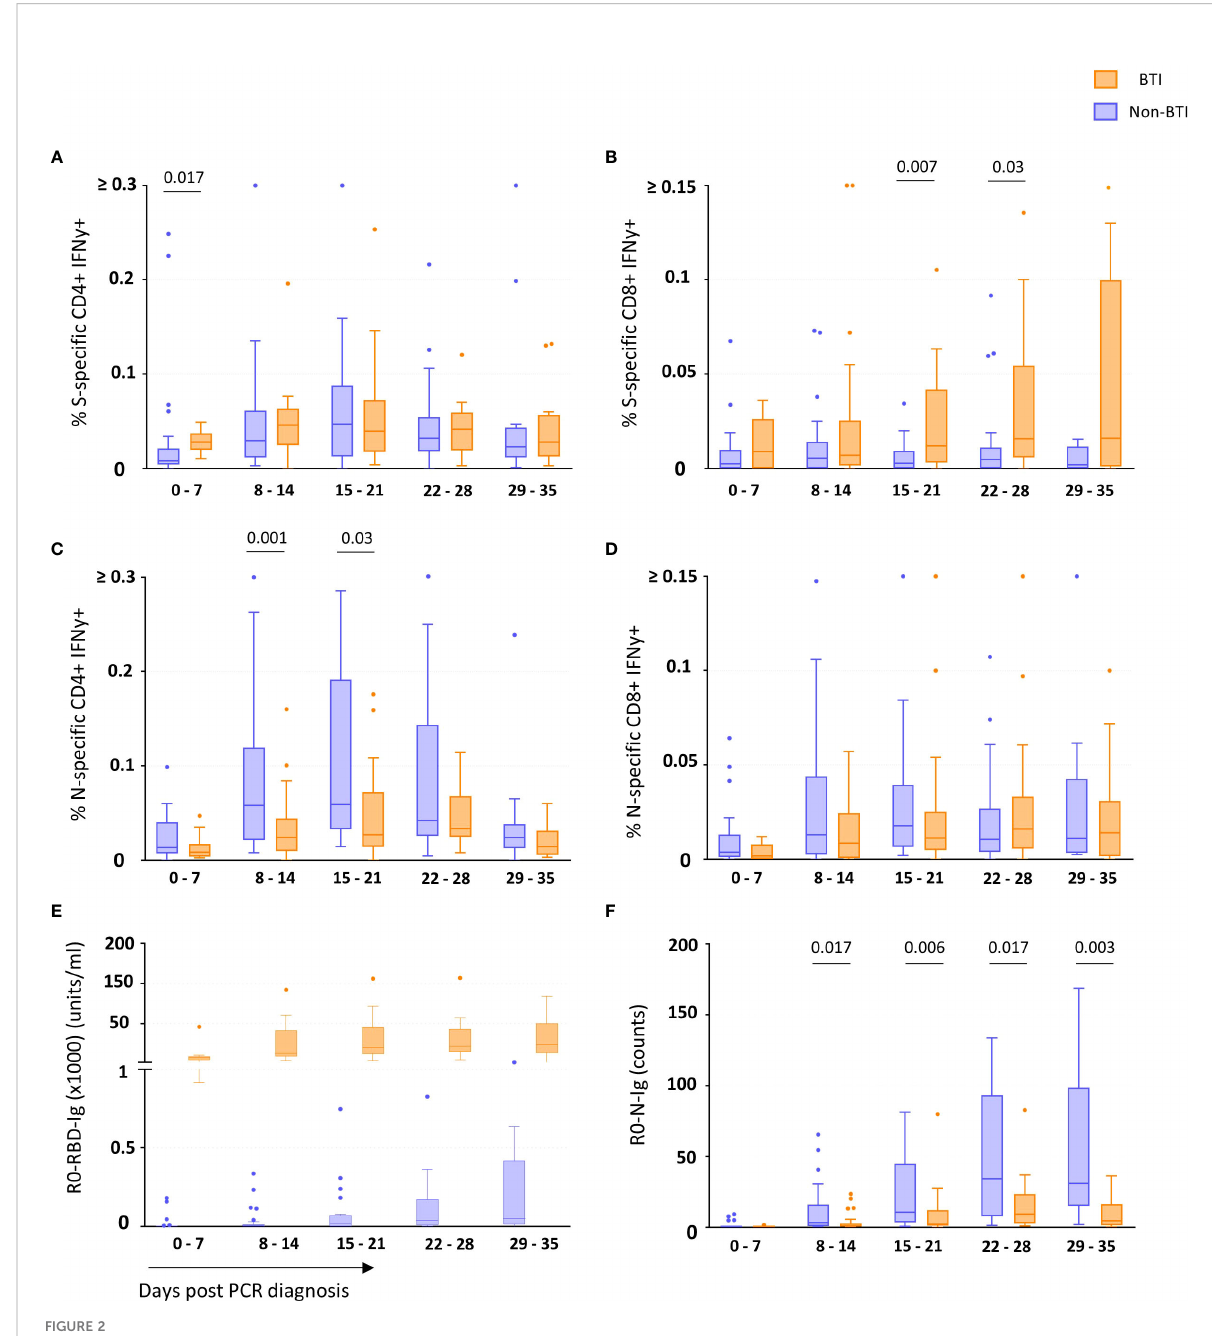
FIGURE 2 T cell and binding antibody responses targeting vaccine-encoded Spike and non-encoded Nucleocapsid protein. The frequency of Spike- speci fi c IFNy+ CD4+ (A) and CD8+ (B) and Nucleocapsid-speci fi c IFNy+ CD4+ (C) and CD8+ (D) T cells and concentration of binding antibodies against the Spike-Receptor Binding Domain (RBD) (E) and Nucleocapsid (N) (F) in breakthrough infections (orange boxes) and non- breakthrough infections (blue boxes) are shown as median and quartiles enclosing 50% of the datapoints, whiskers extend up to the last point inside 1.5*(IQ3 - IQ1) range (Tukey de fi nition). Speci fi c T cell responses were detected after in vitro antigen-stimulation of freshly isolated PBMCs, while the speci fi c antibody concentrations (Spike-RBD) or counts (Nucleocapsid) (Y-axis) consider all Ig isotypes and were determined using the Roche Elecsys test. The days since fi rst diagnosis by PCR are indicated on the x-axis. Statistical comparisons between the groups were performed using the Mann-Whitney t test. p-values below 0.05 are indicated for fi gure 2 (A – F) Spike-RBD binding Ig concentrations signi fi cantly differed between the groups during all 5 weeks post